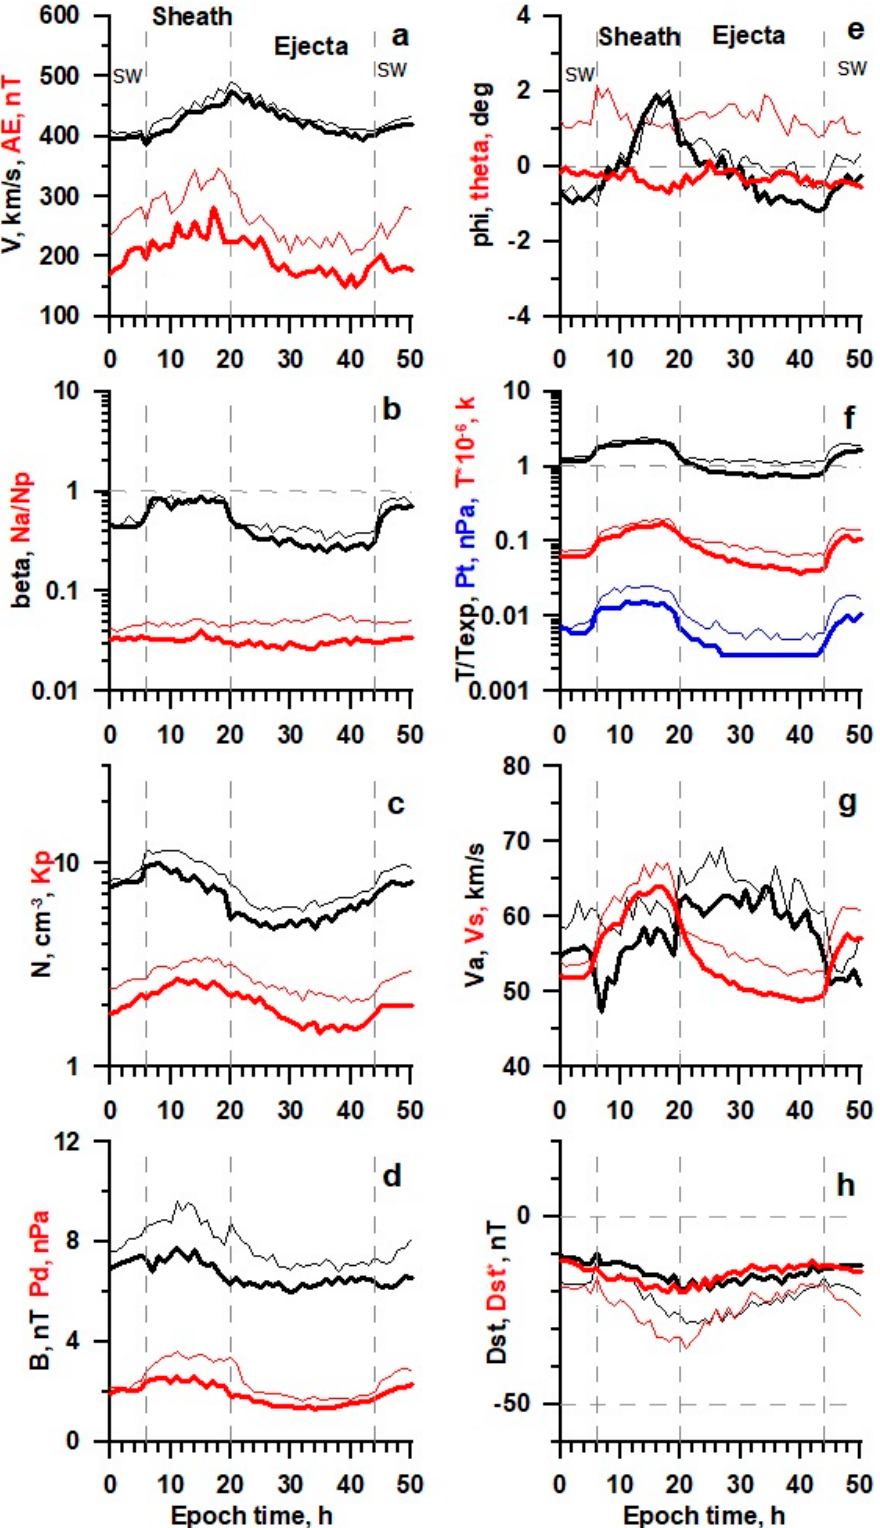
Figure 4. The temporal profile of solar wind and IMF parameters (see legend in the text) for Sheath/Ejecta obtained by the double superposed epoch analysis for 188 events in 21–22 SCs (thin lines) and 138 events in 23–24 SCs (thick lines).